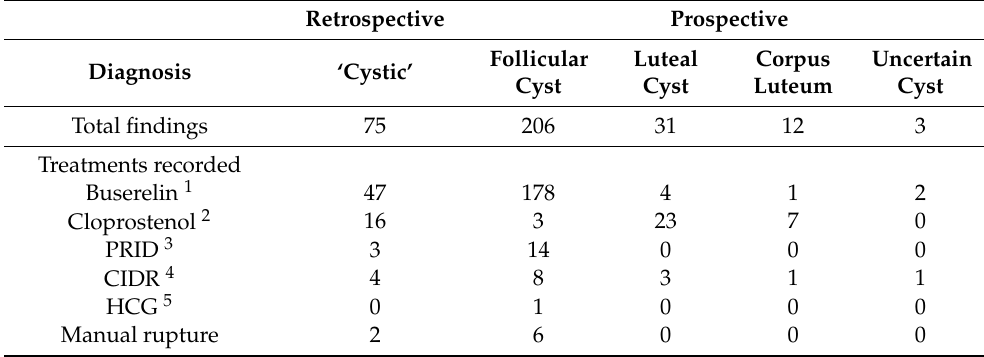
Table 4. Recorded diagnoses and treatments during Practice 1 clinical audits.